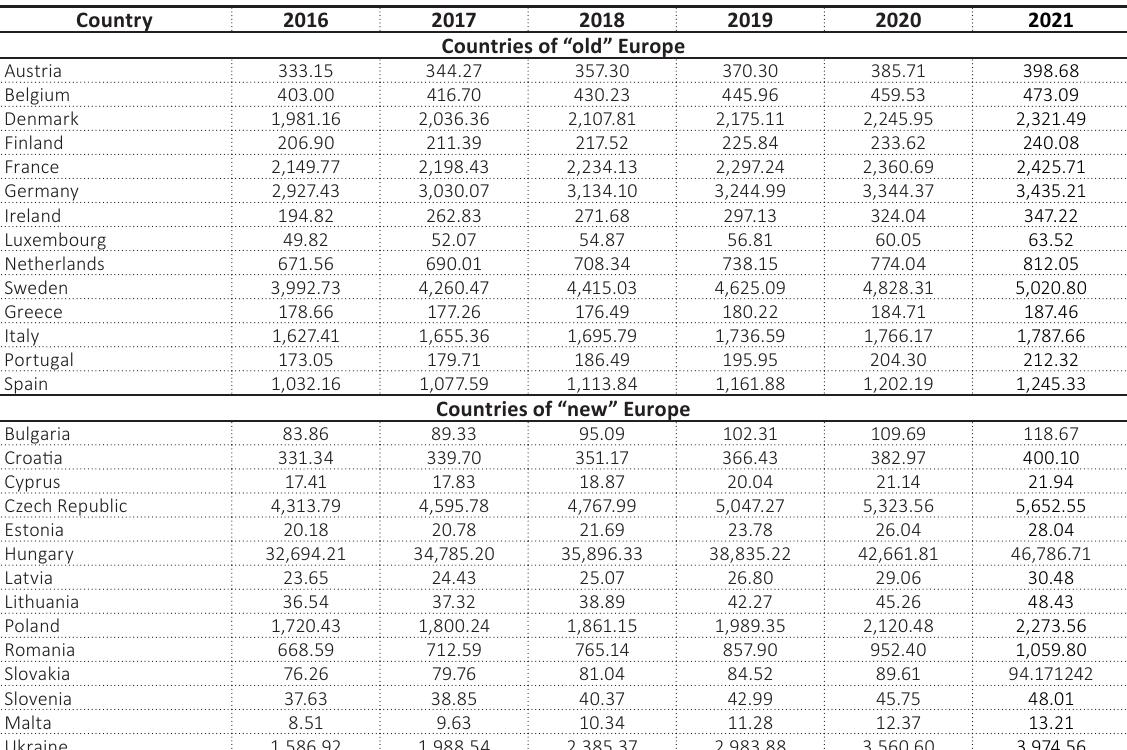
Table E1. GDP in current prices, billion (Y)